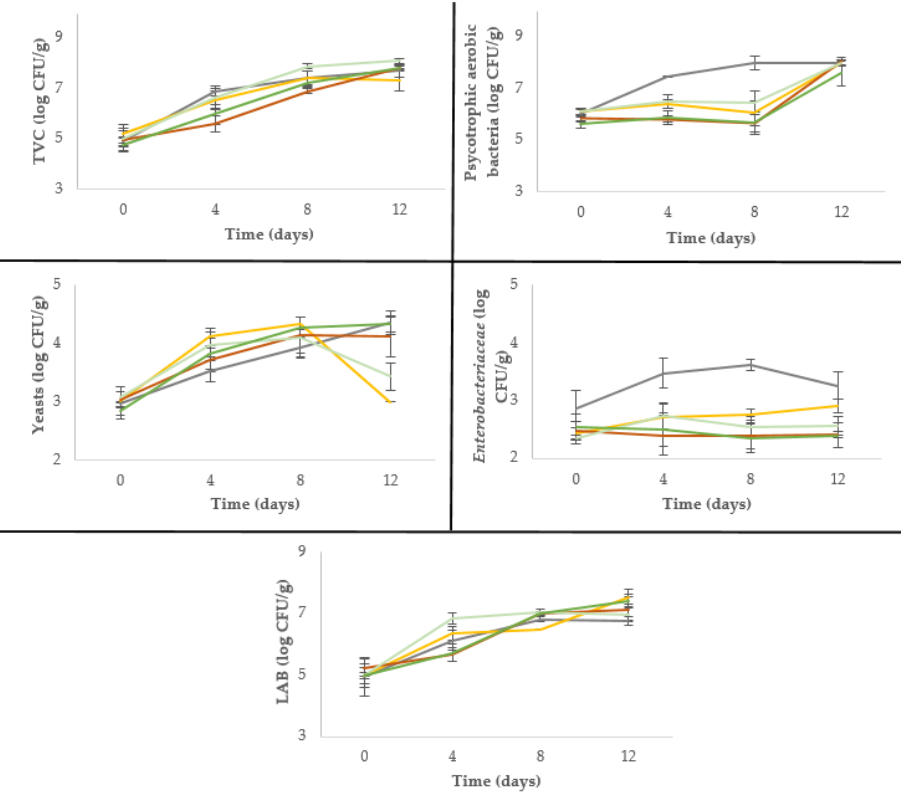
Figure 1. Modifications in microbial counts of deer burgers packed in MAP during chilled storage.